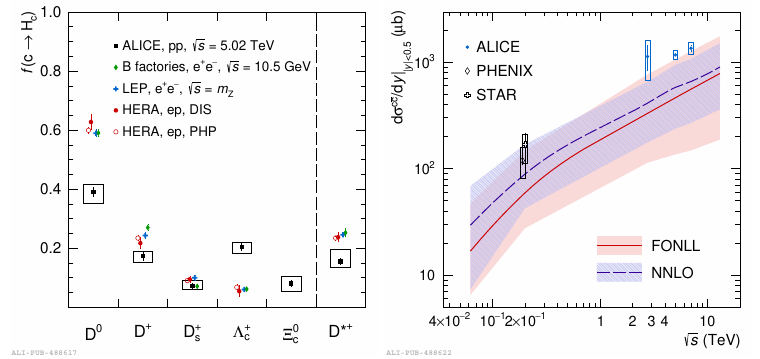
Figure 1. Left: The Λ + c / D 0 ratio as a function of p T measured in pp collisions at √ s = 5 . 02 TeV / D 0 and Ξ + / D 0 ratios measured in pp collisions at √ s = 13 TeV [8]. Right: The [7]. Middle: The Ξ 0 c c / D 0 measured in pp collisions at √ s = 13 TeV. All the charm baryon-to-meson yield ratios are Ω 0 BR c × Figure 2. Left: Charm-quark fragmentation fractions into charm hadrons measured in pp collisions compared to theoretical calculations [2–5, 11]. at √ s = 5 . 02 TeV in comparison with experimental measurements performed in e + e − and ep colli- sions [18]. Right: Charm production cross section at midrapidity per unit of rapidity as a function of the collision energy at the LHC [18] and RHIC [14, 15] compared to FONLL [16] and NNLO [17]